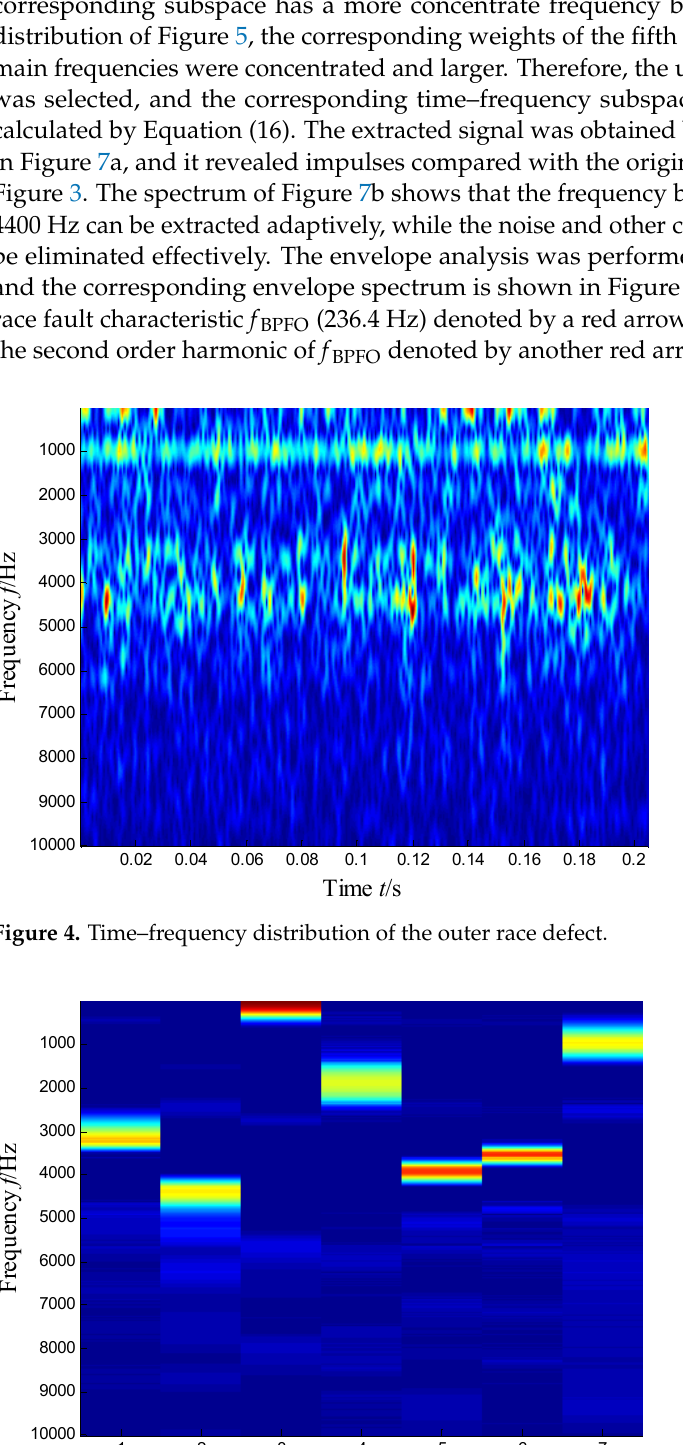
Figure 5. Coefficient matrix obtained by SKNMF.